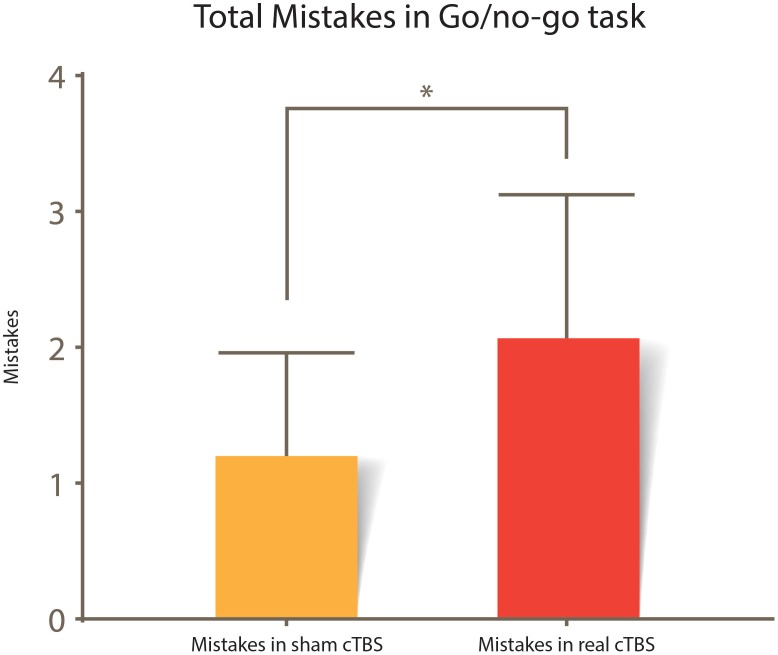
Total mistakes committed in the Go/no-go task. A statistical difference between sham vs. real cTBS conditions is noted t(14) = 3.166, p = 0.007. Error bars represent 95% CI.